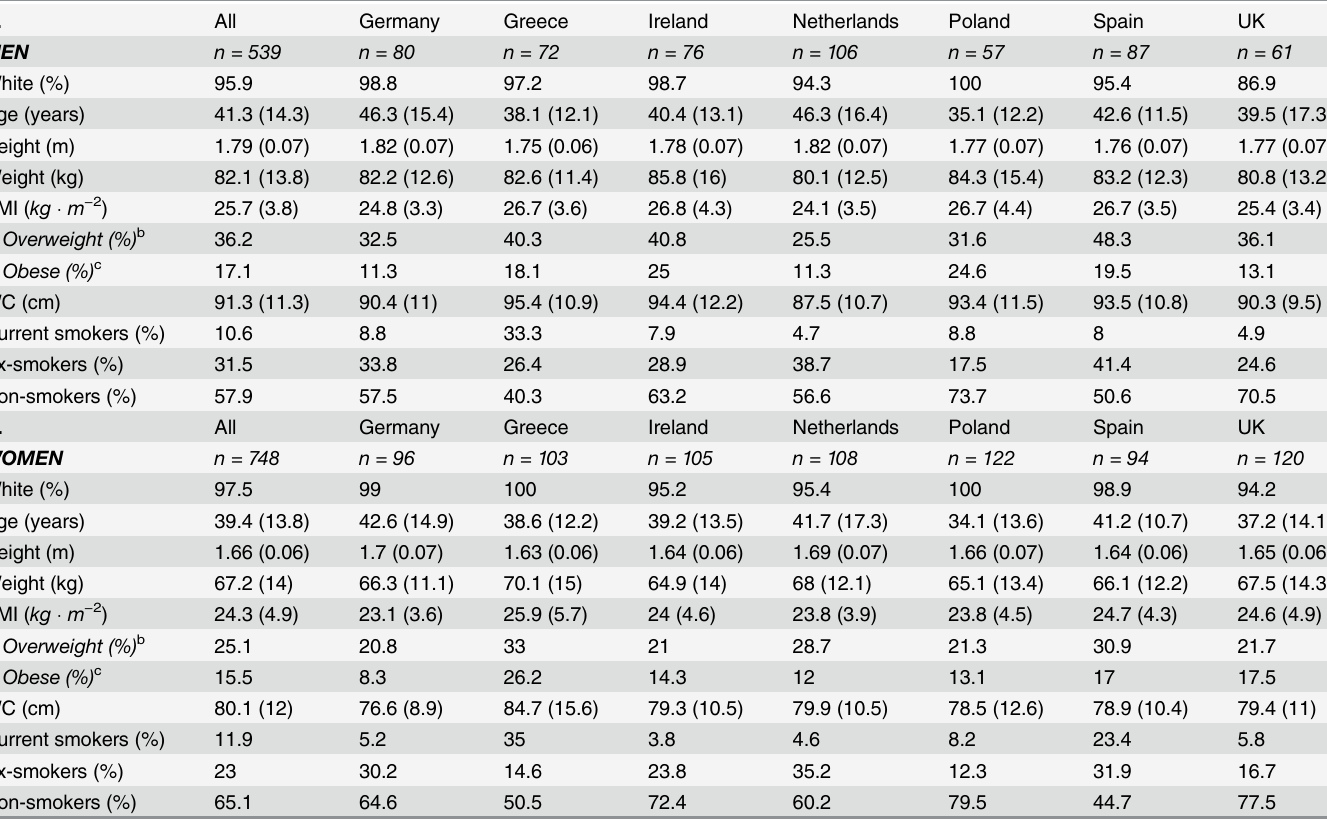
Table 1. Characteristics of the 1287 adults enrolled in the Food4Me Study, with sufficient accelerometer data a